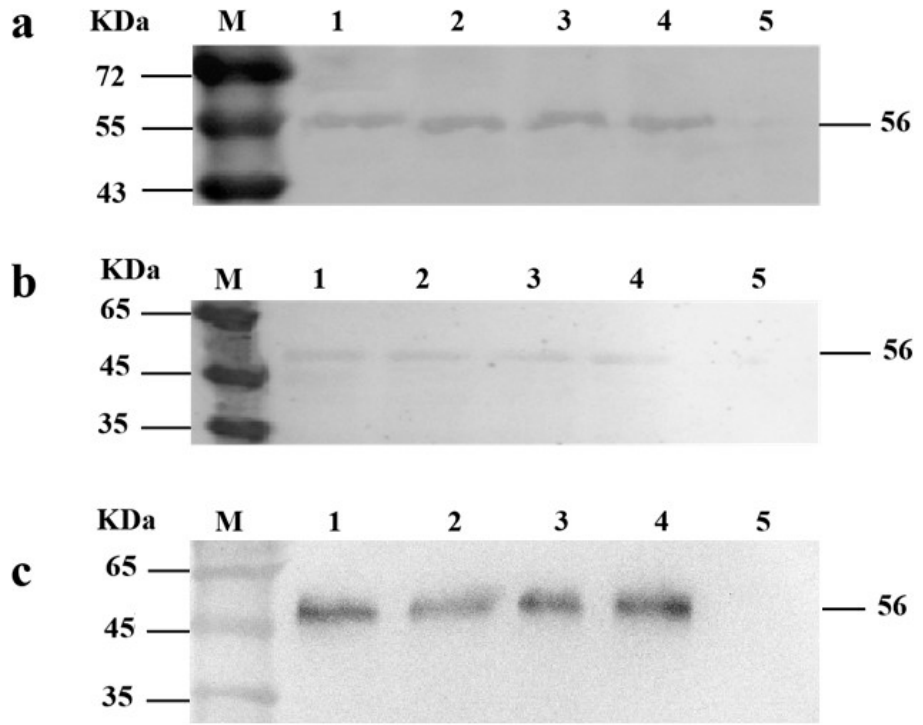
Figure 4. The results of Western blotting: M: maker; ( a1 ) supernatant protein of 10 h; ( a2 ) supernatant protein of 12 h; ( a3 ) supernatant protein of 14 h; ( a4 ) supernatant protein of 16 h; ( a5 ) negative control; ( b1 ) intracellular soluble protein of 10 h; ( b2 ) intracellular soluble protein of 12 h; ( b3 ) intracellular soluble protein of 14 h; ( b4 ) intracellular soluble protein of 16 h; ( b5 ) negative control; ( c1 ) inclusion protein of 10 h; ( c2 ) inclusion protein of 12 h; ( c3 ): inclusion protein of 14 h; ( c4 ) inclusion protein of 16 h; ( c5 ) negative control.